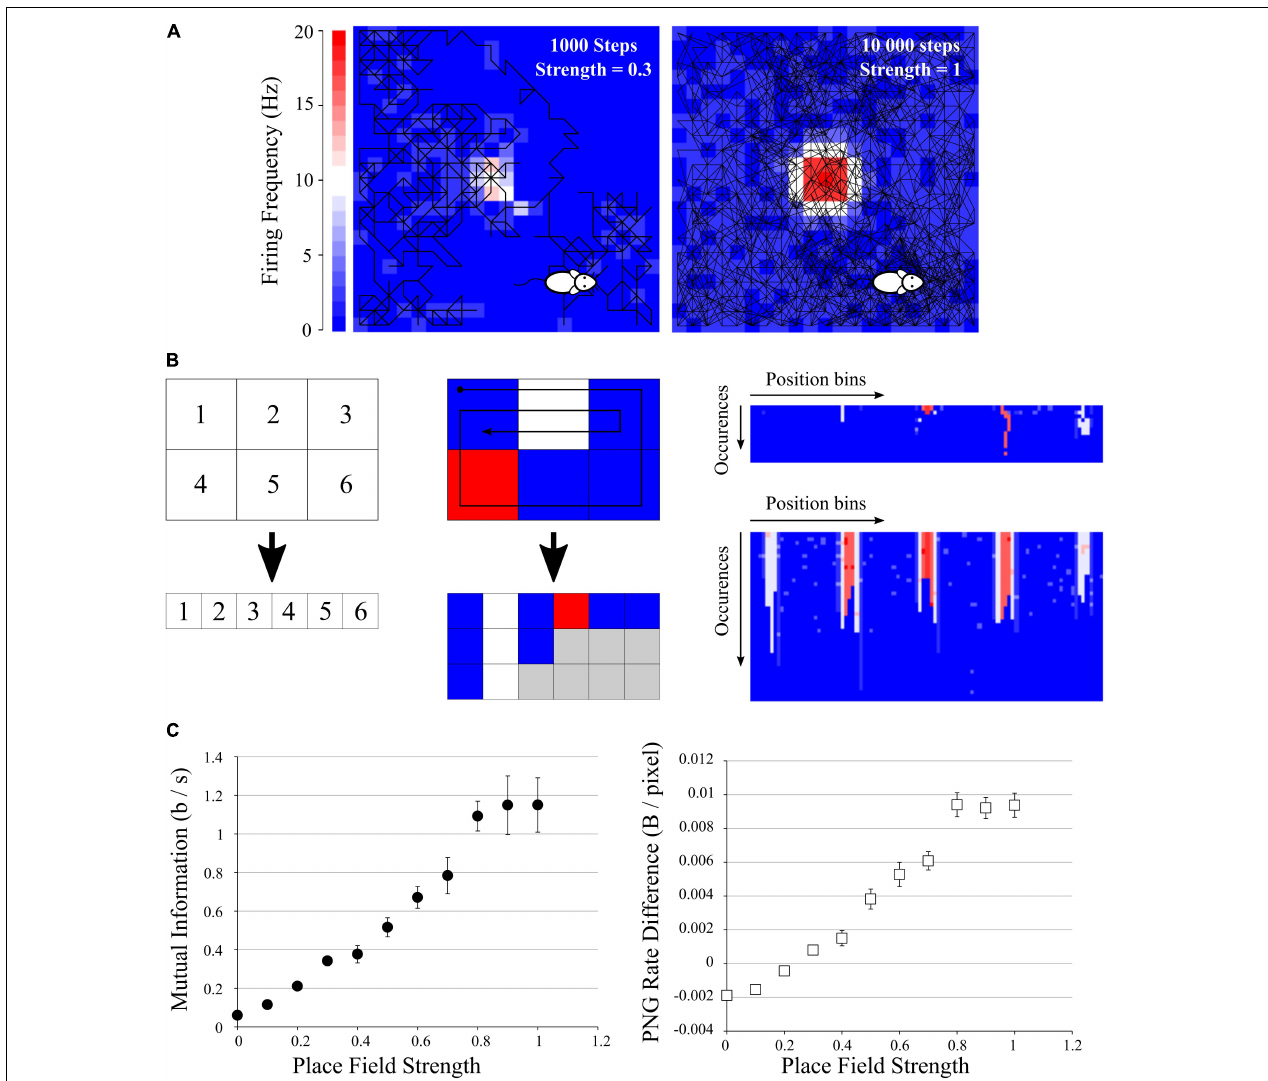
FIGURE 5 | Application to mutual information from place fields. (A) Examples of simulated data: a mock animal with a random walk in an enclosed environment. The firing rate of each space bin was modeled as a Gaussian-like centered in the field, with growing probability of firing. Left: example of a 1,000-steps random walk with a place field of low probability of firing ( p = 0.3). Middle: example of a 10,000-steps random walk with a place field of high probability of firing ( p = 1). (B) Simple explanation of the pairing function used to transform the Place field information to a 2D array to be saved in PNG format. Left, top: example of an area divided in 6 space bins, and each bin is given a unique index, which will be the index of the columns of the future image (left, bottom). Middle: if we follow the patch showed with the arrow, we traverse the indexes 1, 2, 3, 6, 5, 4, 1, 2, 3, 2, 1. For each traversed index, we place a pixel with the color corresponding to the firing frequency at the corresponding column index. If we go to the same position multiple times, we simply add multiple rows to the 2D array. There will be “holes” (gray squares) as the path did not go to every position the same number of times, but we can fill them with 0 (blue squares). We end up with a 2D array with the number of columns corresponding to the number of space bins (6 in this example) and the number of rows corresponding to the number of times the path entered the same space bin (3 for this short example, as the path entered the space bins 1 and 2 three times). Right: result of this pairing function on the 20 × 20 arena for the example seen in (A) , left (top) and (A) , right (bottom). These files were saved as PNG, rotated, saved again to obtain the difference in PNG Rates. (C) Left: Mutual Information as I sec (Eq. 9) versus Place Field strength, showing a clear increase when the place field has a high chance to fire. Right: Difference in PNG Rates versus Place Field strength. Both curves are